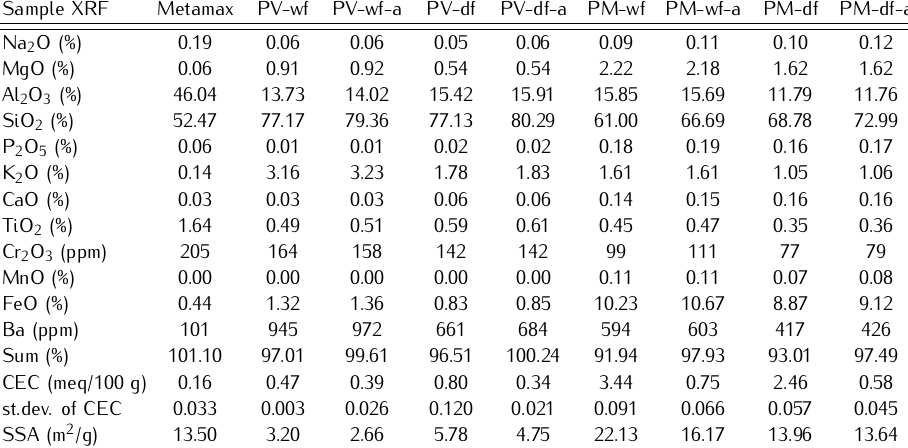
Table 1. Chemical compositions, CEC and SSA of samples. Sample